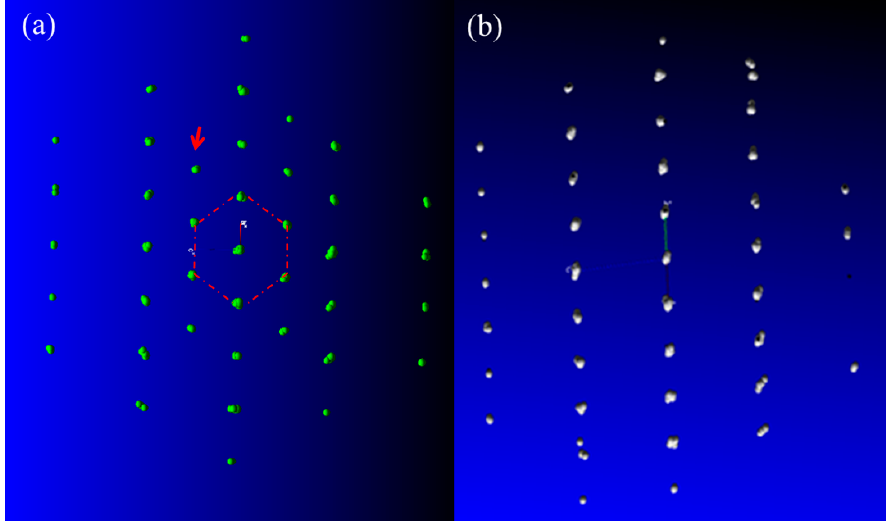
Figure 2. Projected reciprocal lattice points along the [110] direction of ( a ) θ -Al 2 Cu phase and ( b ) the pseudo Al 2 Cu phase.